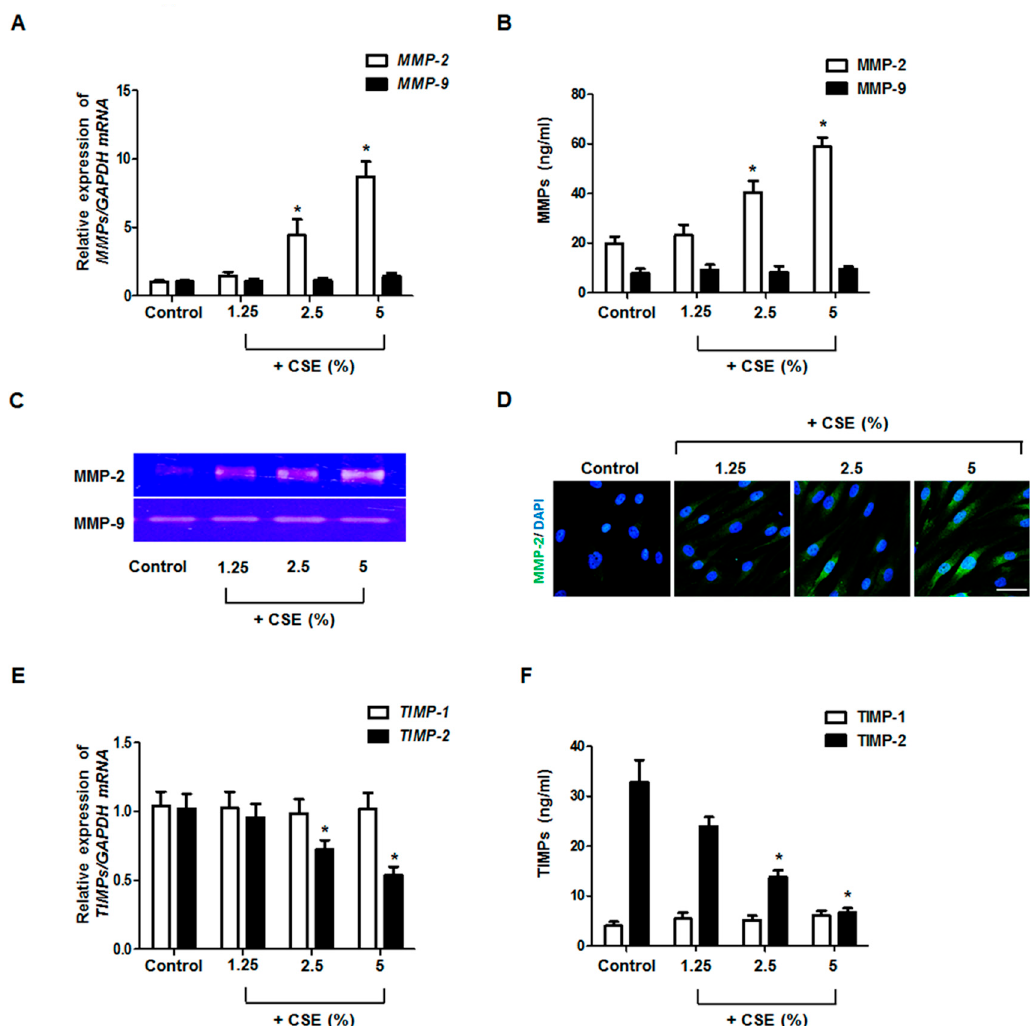
Figure 1. Effect of CSE on MMP and TIMP expression in nasal fibroblasts. After treatment of nasal fibroblasts with 5% CSE, the mRNA levels of MMPs and TIMPs were measured using real-time PCR ( A and E ), and MMP and TIMP protein expression levels were determined using ELISA ( B and F ). The enzymatic activities of MMP-2 and MMP-9 were measured by gelatin zymography ( C ). The expression and localization of MMP-2 protein (green) were observed using immunofluorescence staining ( D ). * p < 0.05 vs. control. Scale bar = 100 μ m.